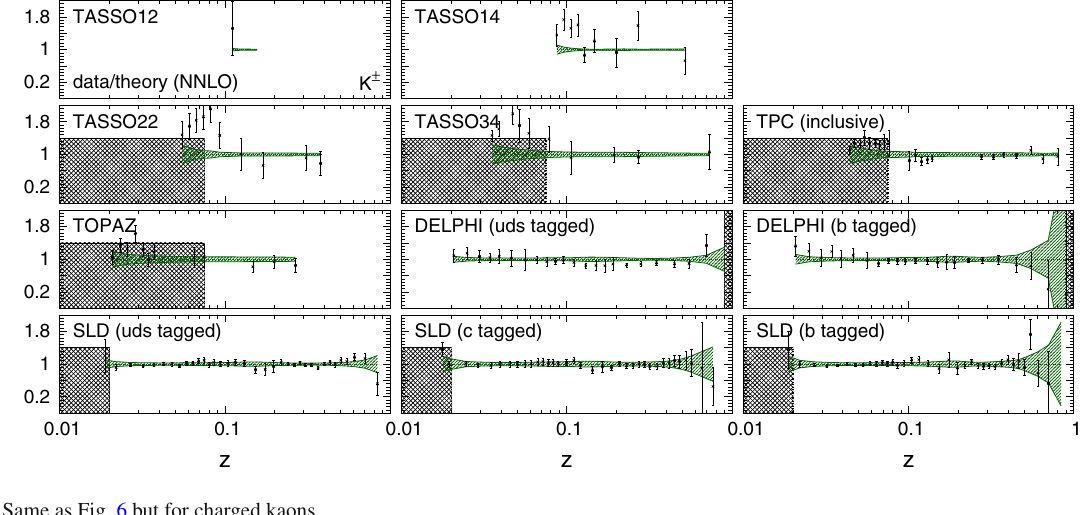
Fig. 7 Same as Fig. 6 but for charged